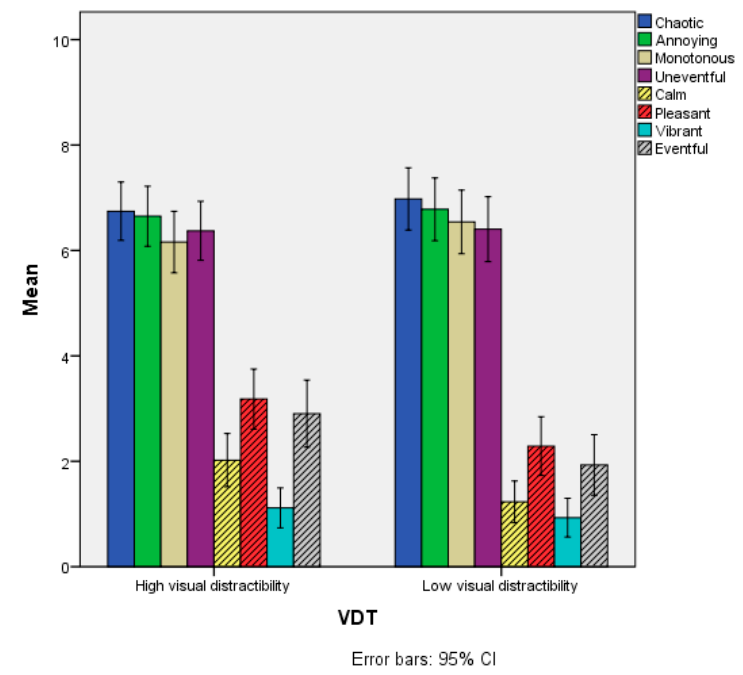
Figure 7. Mean scores of the Soundscape appraisal items as a function of the VDT variable. Grey-shaded bars refer to items where statistically significant differences were observed between the two groups.